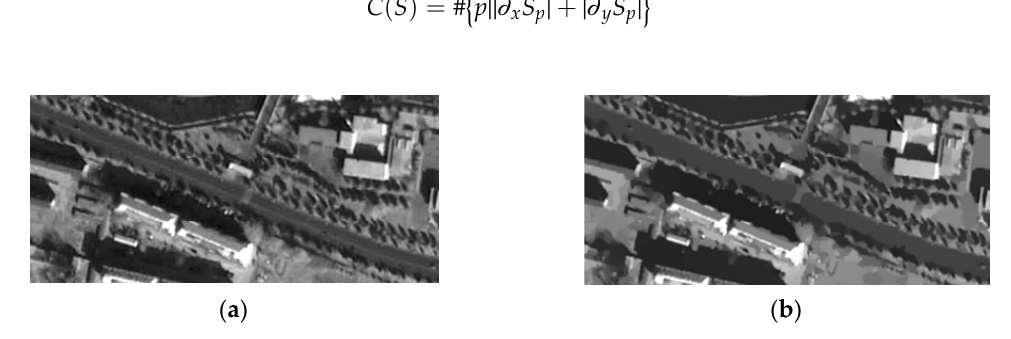
Figure 2. L 0 smoothing result. ( a ) Input image; ( b ) result of filtering.